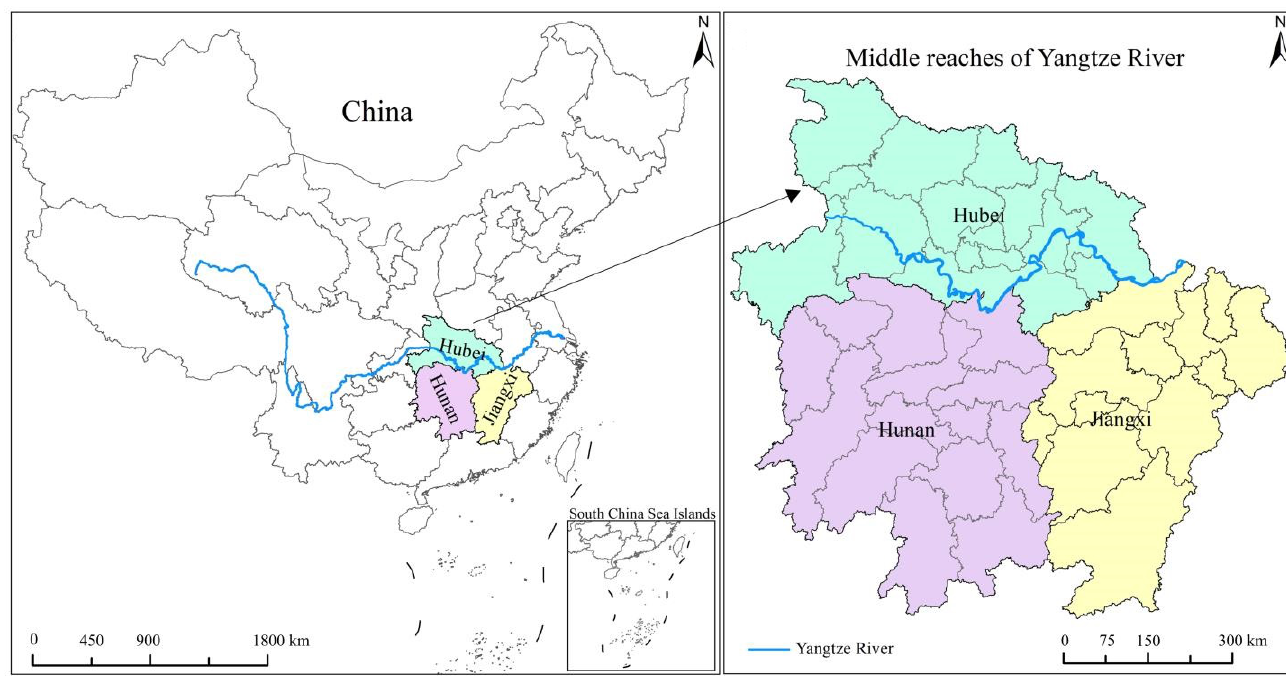
Figure 2. Study Figure 2. Study area.